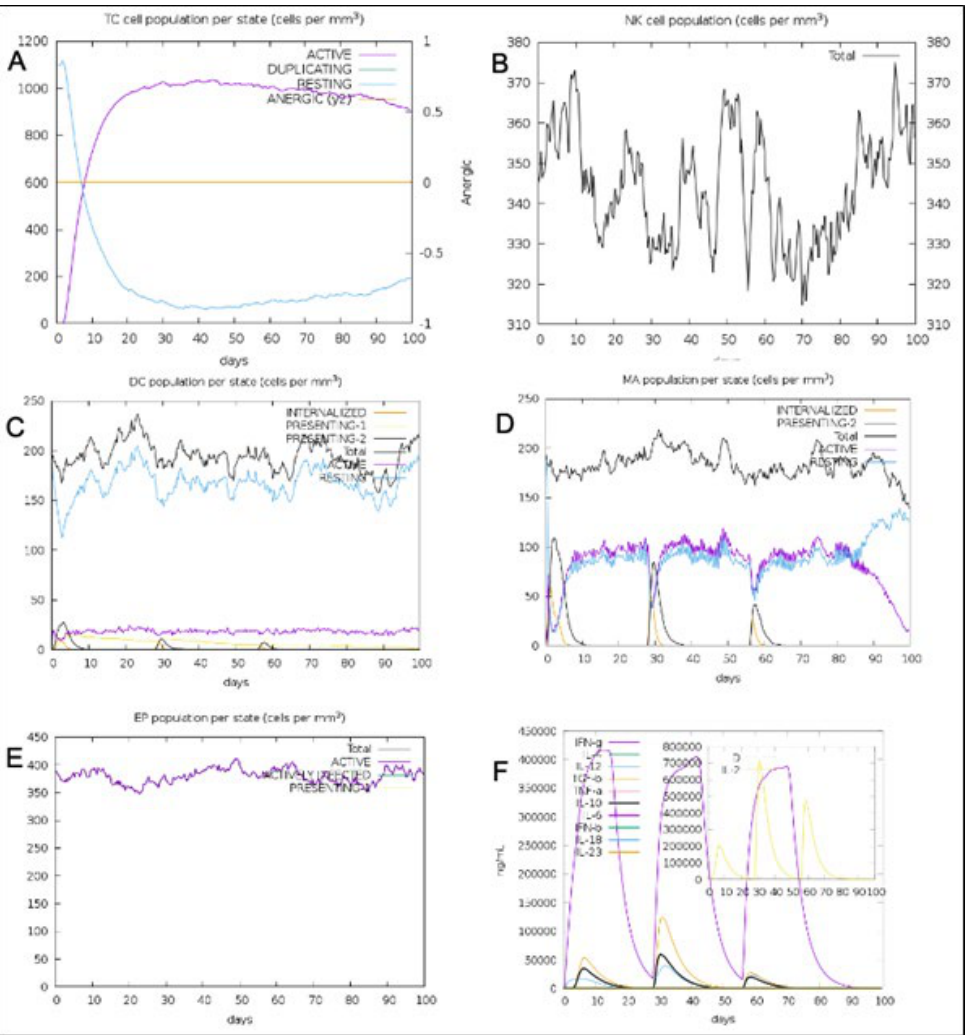
Fig. 12. (A) T-cell population per state (B) NK cell total count (C) Dendritic cell population per state (D) Macrophage population per state (E) Epithelial cell population per state (F) Cytokines concentration including interleukins and